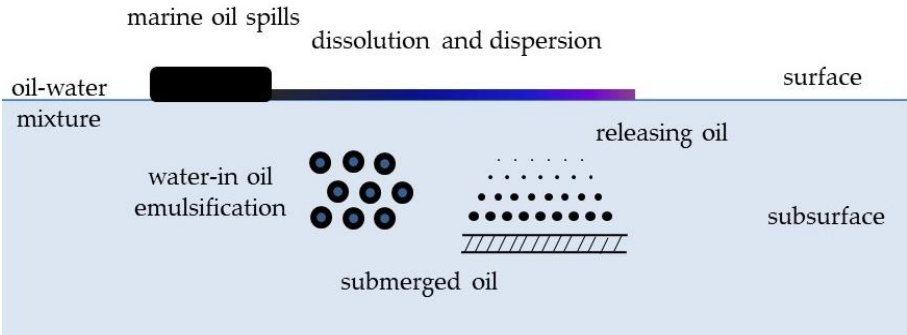
Figure 1. Complex mixture derived from oil propagation in water.